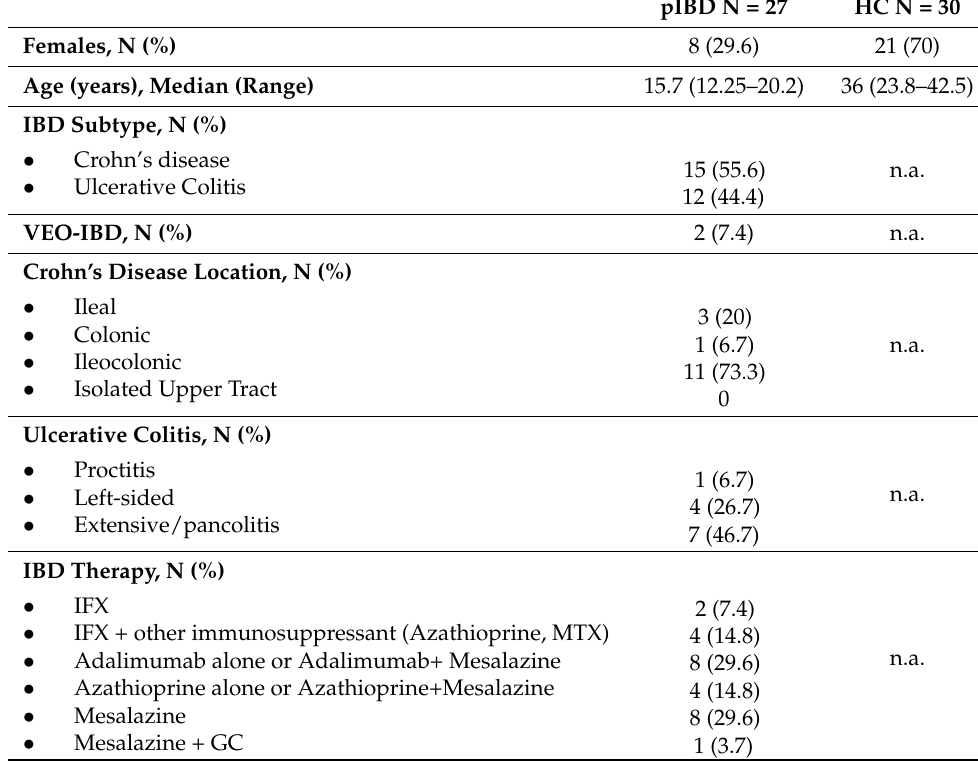
Table 1. Characteristics of the study